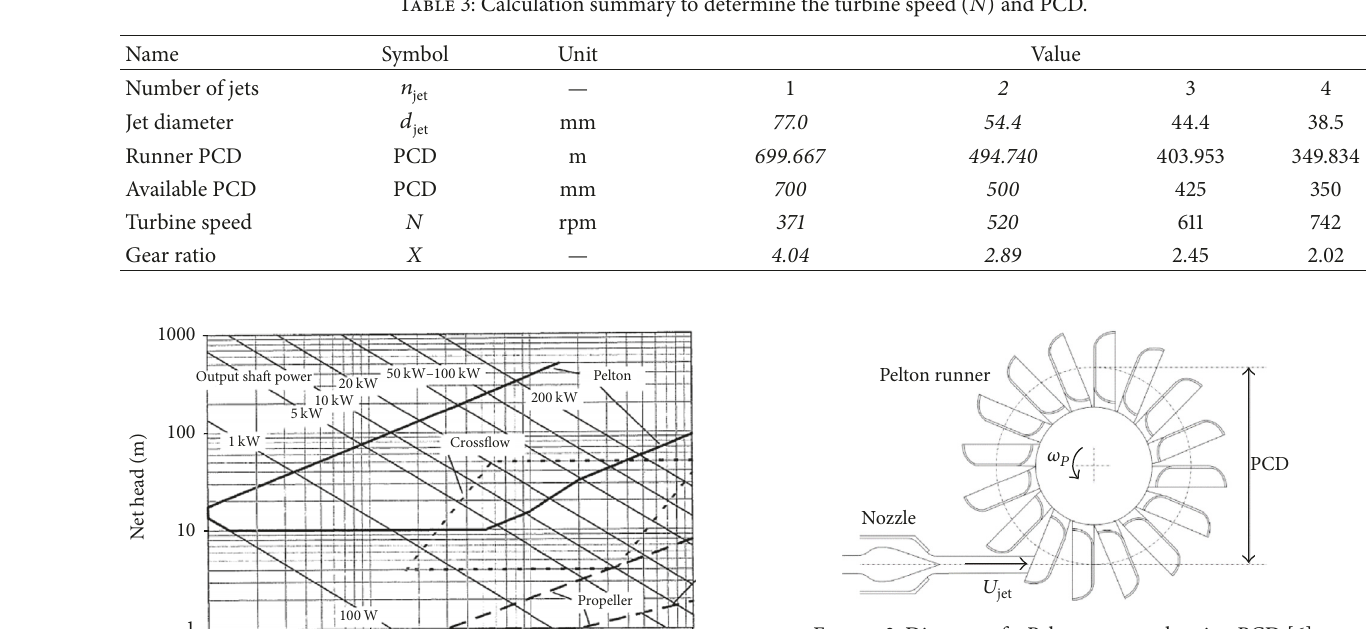
Figure 3: Diagram of a Pelton runner showing PCD